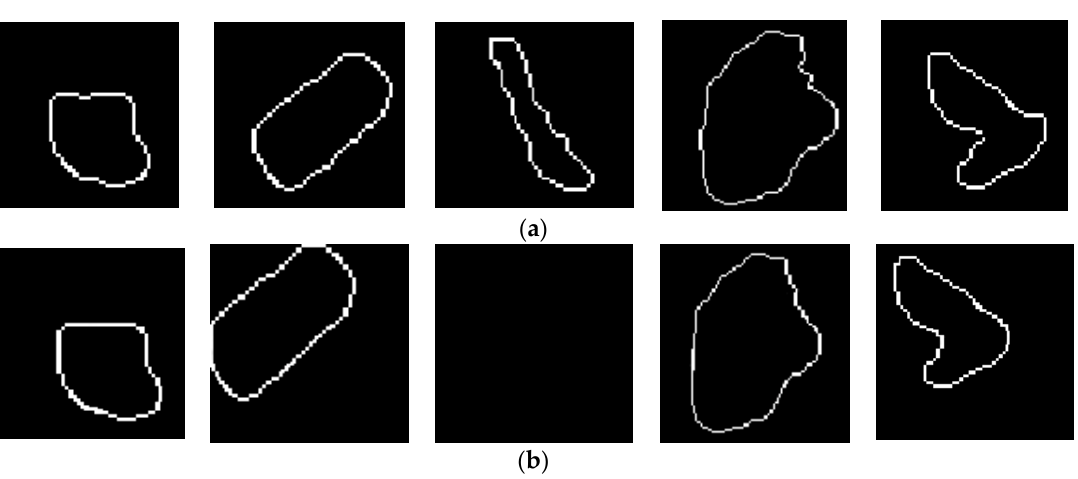
Figure 5. Comparison of tracking results of surface defects: ( a ) defect a ; ( b ) defect b ; ( c ) defect c ; ( d ) defect d ; ( e ) defect e .